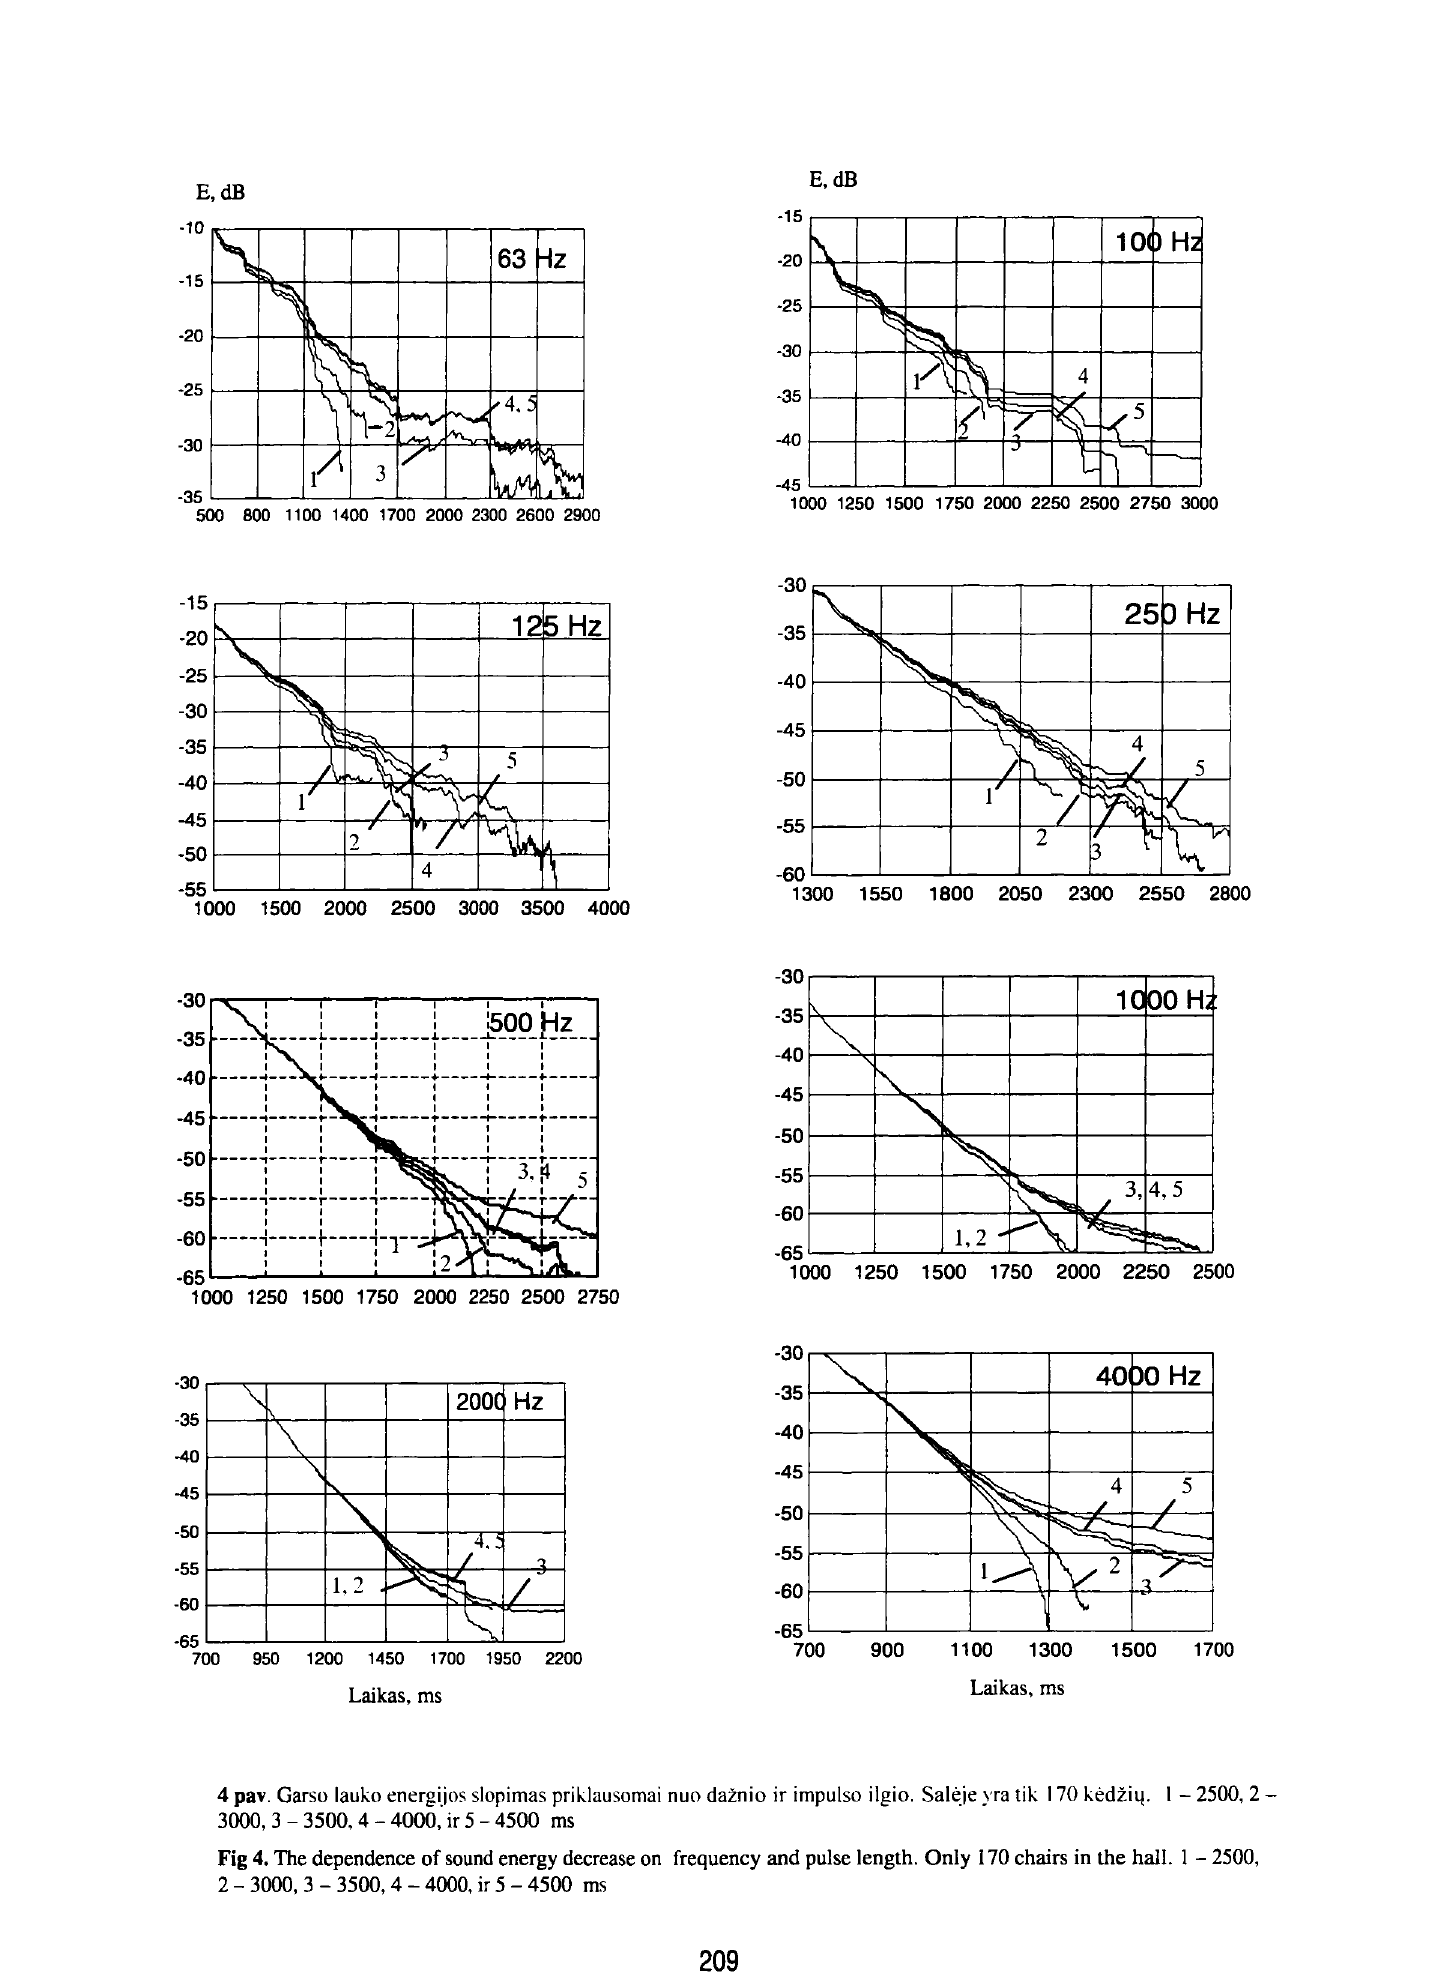
4 pav. Garso lauko energijos slopimas priklausomai nuo daznio ir impulso ilgio. Saleje yra tik 170 kedzi4. I - 2500, 2- Fig 4. The dependence of sound energy decrease on frequency and pulse length. Only 170 chairs in the hall. I - 2500, 2 - 3000, 3 - 3500, 4 - 4000, ir 5 - 4500